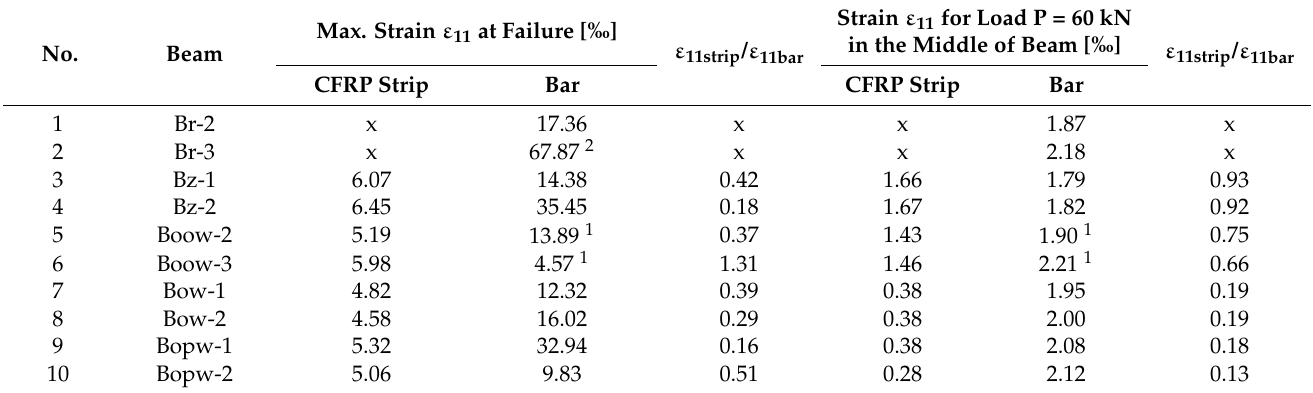
Table 4. Values of strains of CFRP strip and the bar in the middle of beam span.